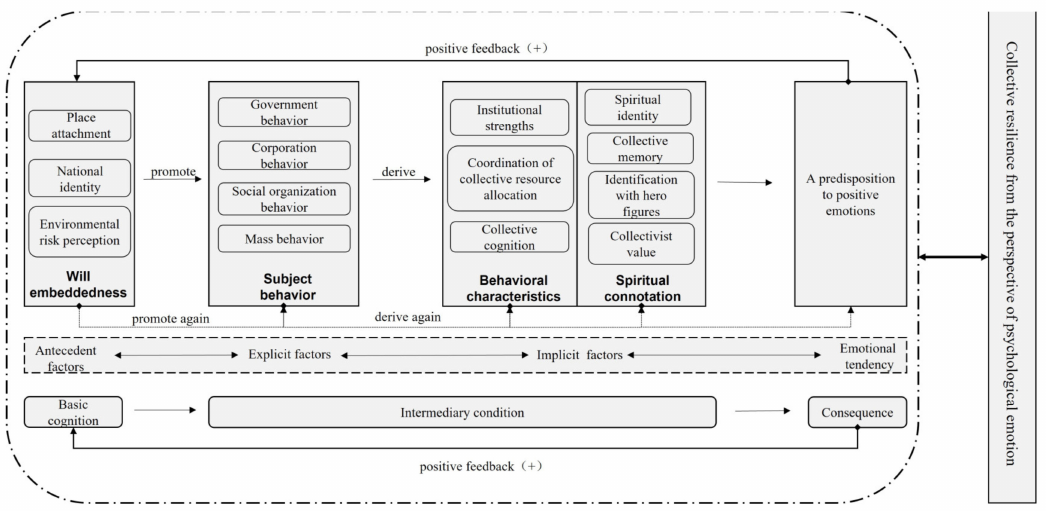
Figure 5. A model of factors influencing collective resilience from a psycho-emotional